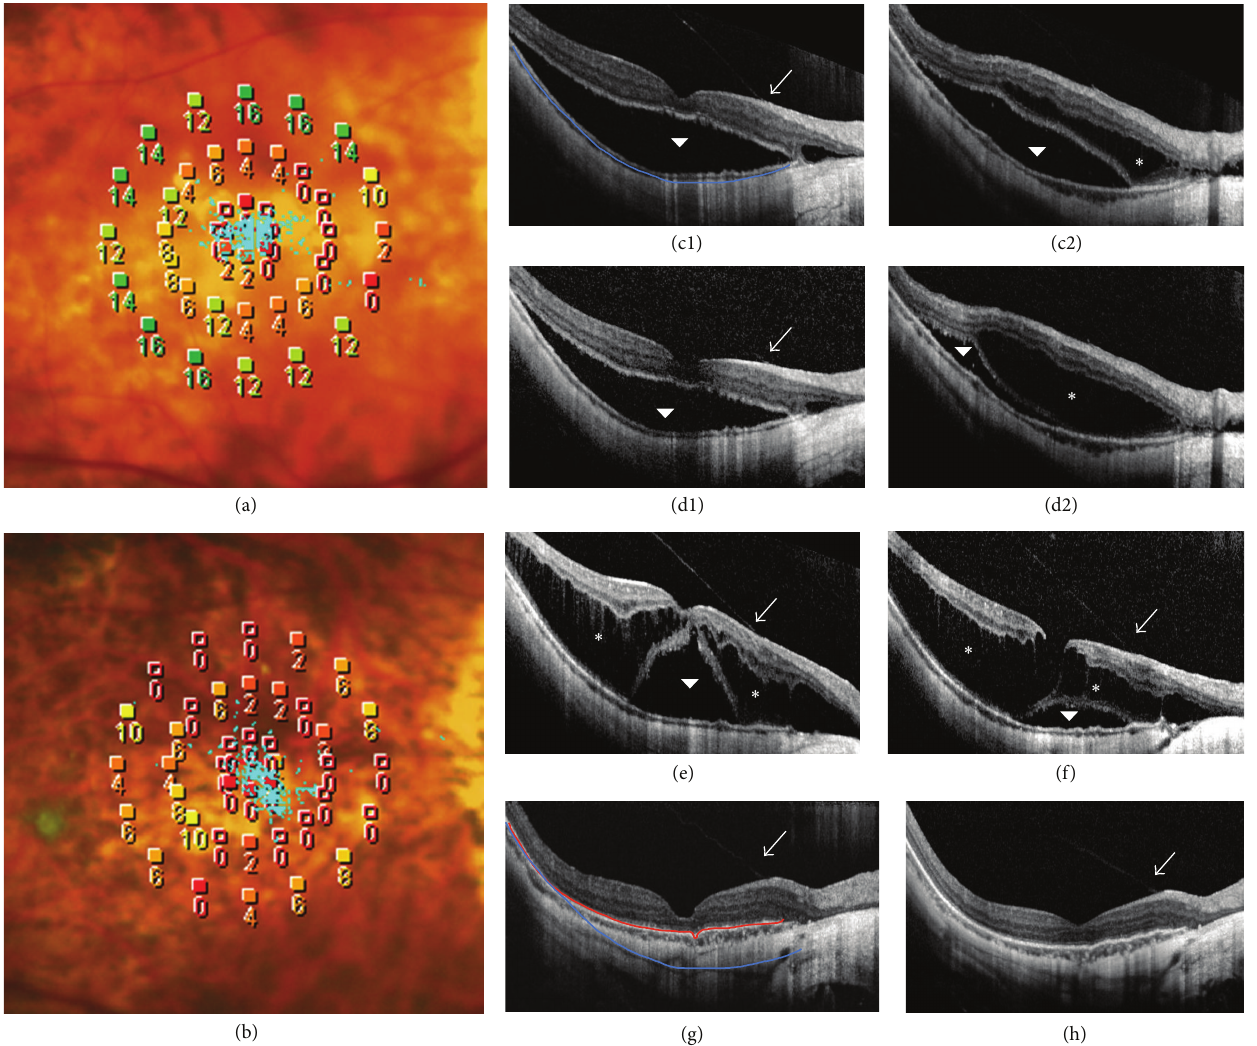
Figure 1: OCT and MP changes in Case 1 during follow-up. (a) Microperimetric image shows that retinal sensitivity was 6.85 dB and fixation was stable at baseline. (b) After 66 months, retinal sensitivity was 2.45 dB and fixation remained stable. (c1) Baseline OCT through the fovea reveals foveal detachment (arrowhead) and an attachment of the vitreous (arrow) apparent at the retinal surface. (c2) Baseline OCT taken inferior to the macula reveals macular retinoschisis (asterisk) and foveal detachment (arrowhead). (d1)-(d2) After 2 months, OCT reveals mild improvement in the foveal detachment but with retinoschisis progression. (e)–(h) OCT through the fovea acquired at 11, 33, 64, and 66 months,